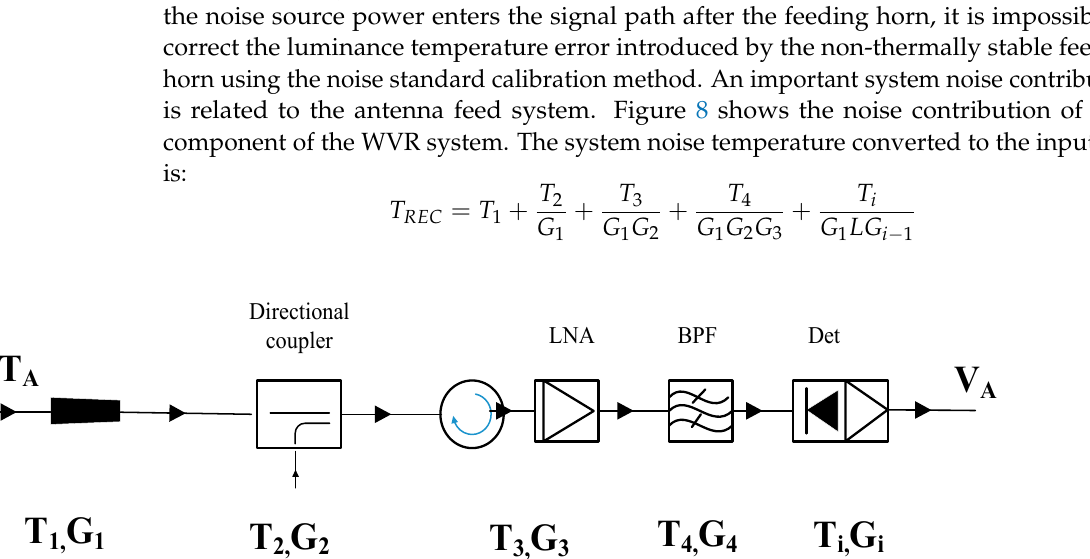
Figure 8. Contribution of WVR components of system noise temperature T REC.